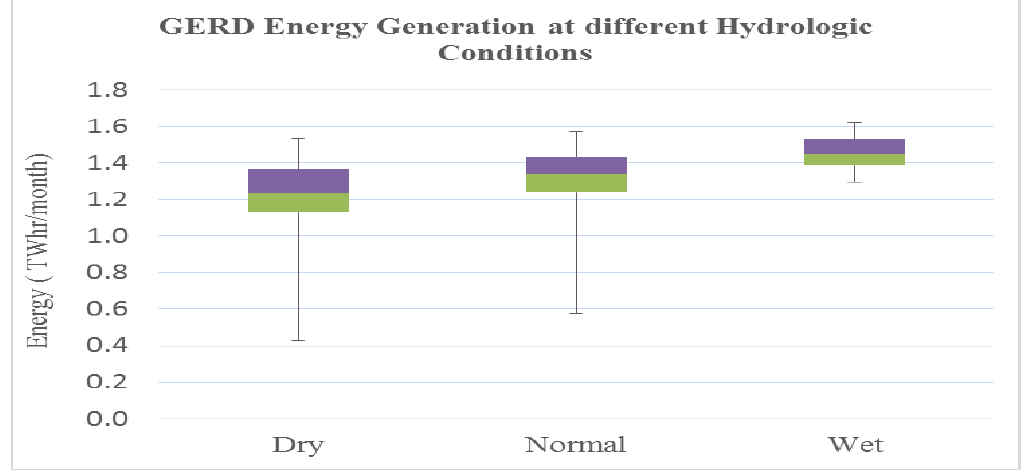
Figure 10. Monthly energy generation of the GERD at three hydrologic conditions.